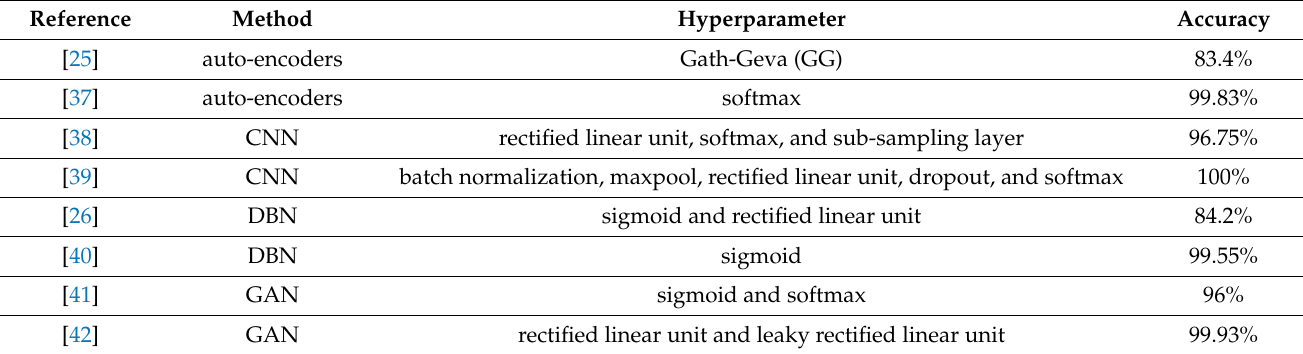
Table 3. Diagnostic performance of different deep learning